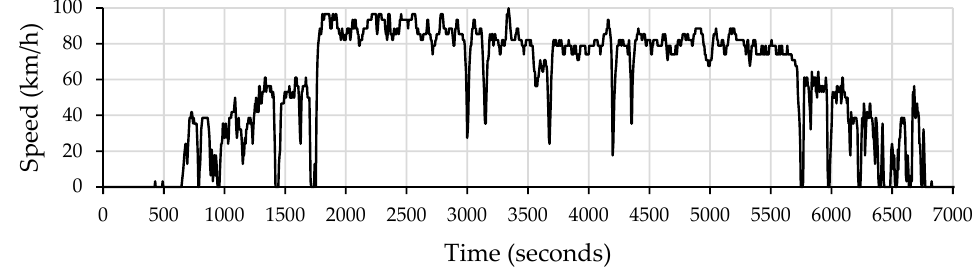
Figure 10. Speed of the vehicle during the extra-urban route.